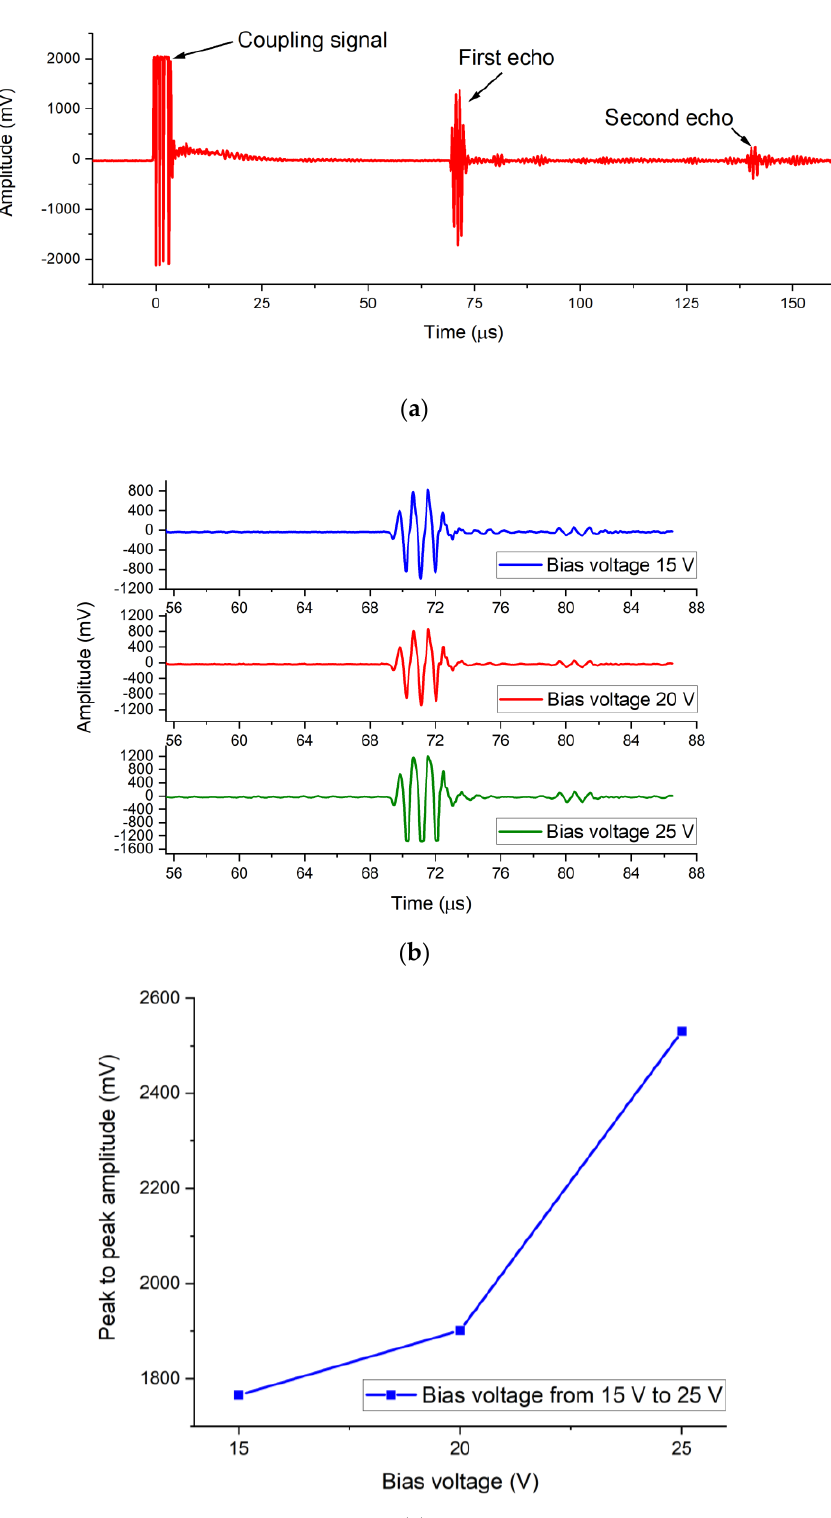
Figure 11. ( a ) Pulse-echo impulse response; ( b ) the first pulse-echo impulse responses when the CMUT device was biased at 15 V, 20 V, and 25 V; ( c ) peak-to-peak amplitude of the first echo signals when the CMUT was driven by different DC bias voltages.